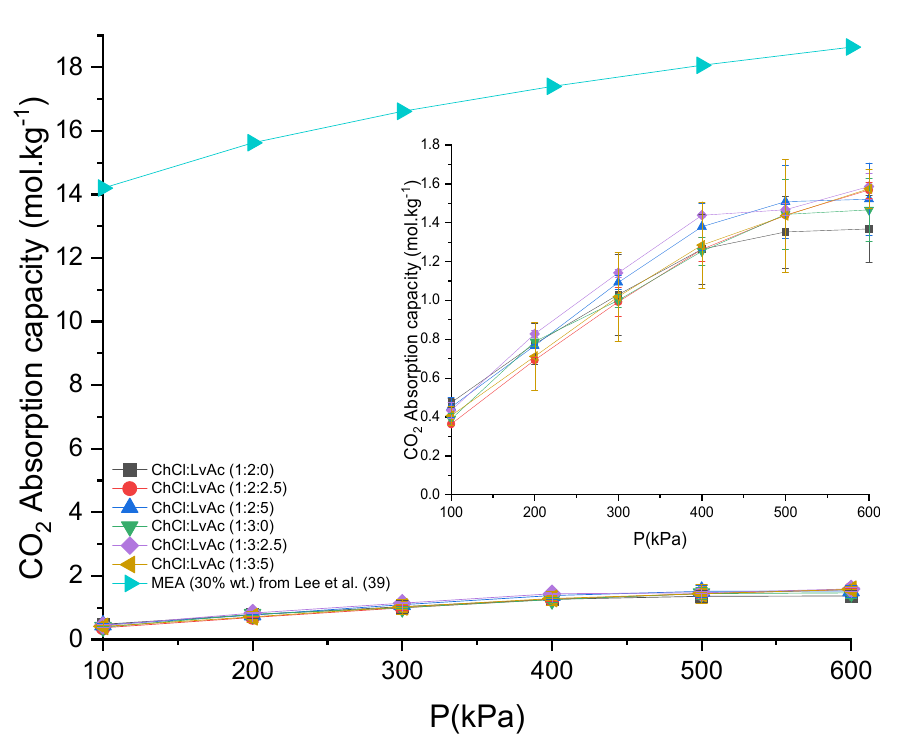
Figure 2. CO 2 absorption capacity of ChCl:LvAc DESs with different compositions at temperatures ranging from 25 °C to